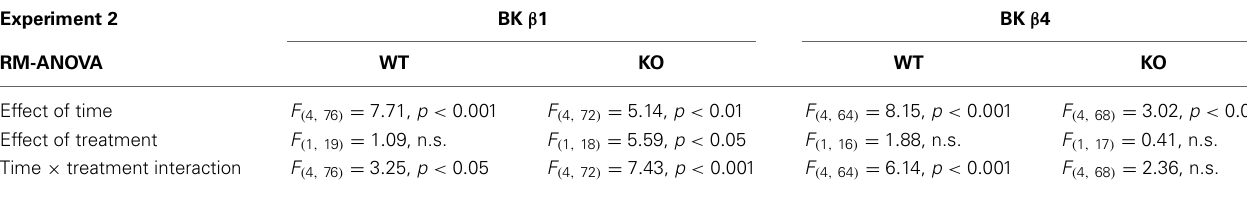
Table 3 | Statistical analysis of the effects of treatment and genotype on ethanol intake during each 2BC week in Experiment 2. Experiment